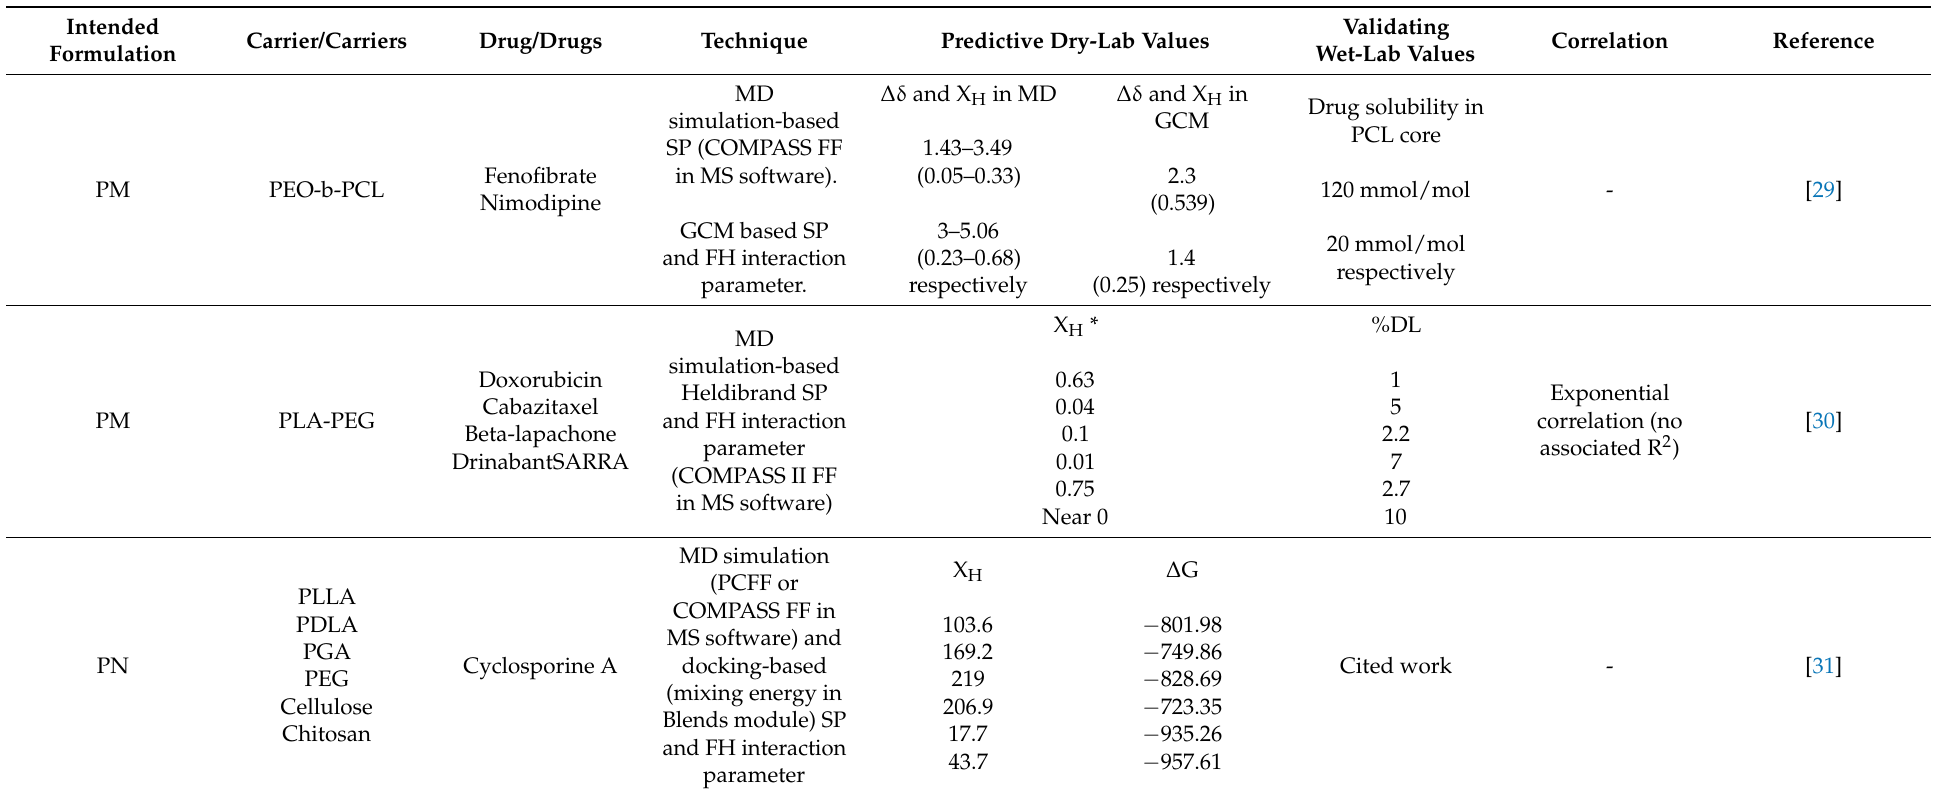
Table 2. Simulations-derived solubility parameters and Flory-Huggins interaction theory for different nanocarriers and their